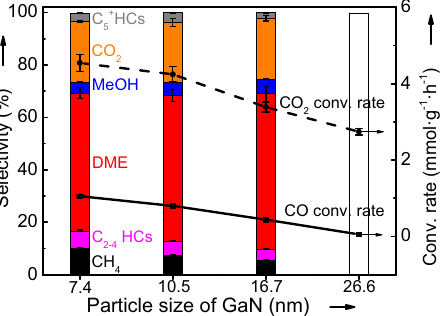
Fig. 5 Catalytic performance for the CO/CO 2 hydrogenation over the GaN catalysts with different particle sizes. Reaction conditions: T = 360 °C, P = 2.0 MPa, gas hourly space velocity = 1000 mL g − 1 h − 1 for the CO hydrogenation and 3000 mL g − 1 h − 1 for the CO 2 hydrogenation, H 2 /CO (CO 2 ) = 2, and time on steam = 40 h. HCs hydrocarbons, Conv conversion. The error bar indicating the relative deviation is within